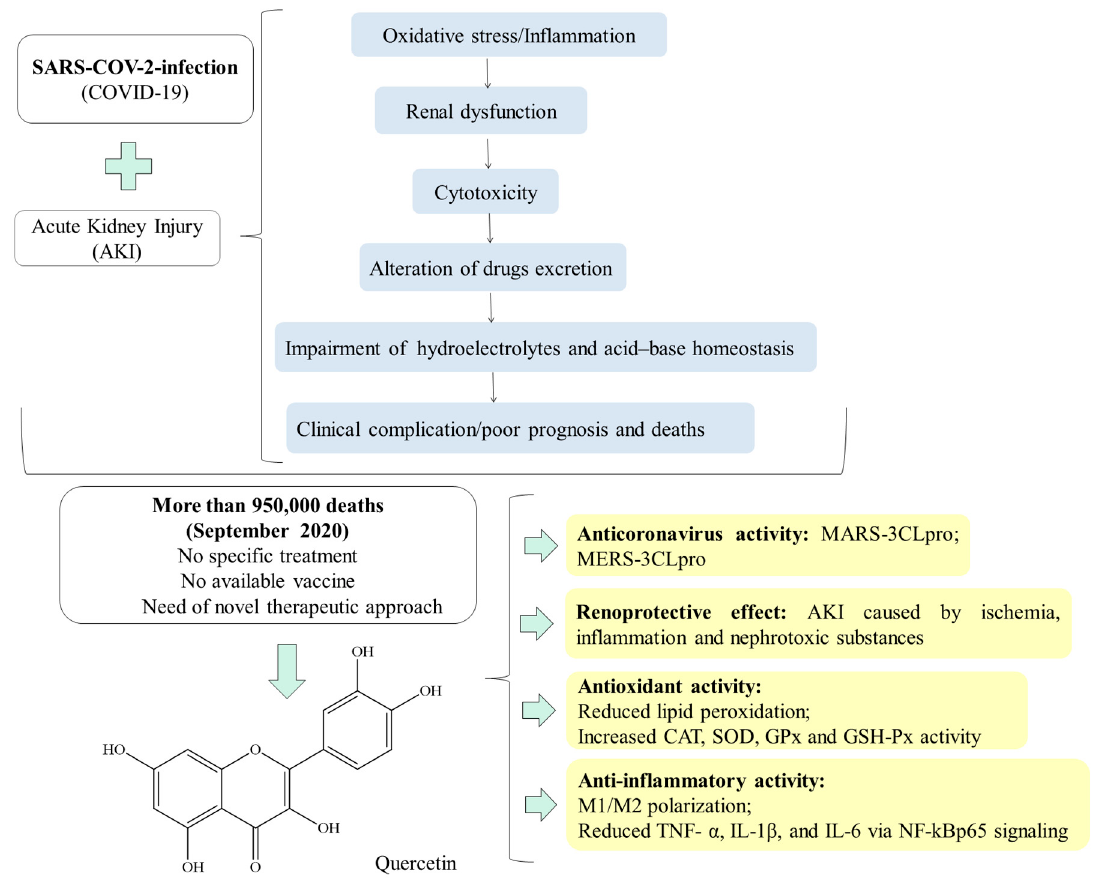
Figure 1. Quercetin as a helpful therapeutic drug against COVID-19-associated AKI.